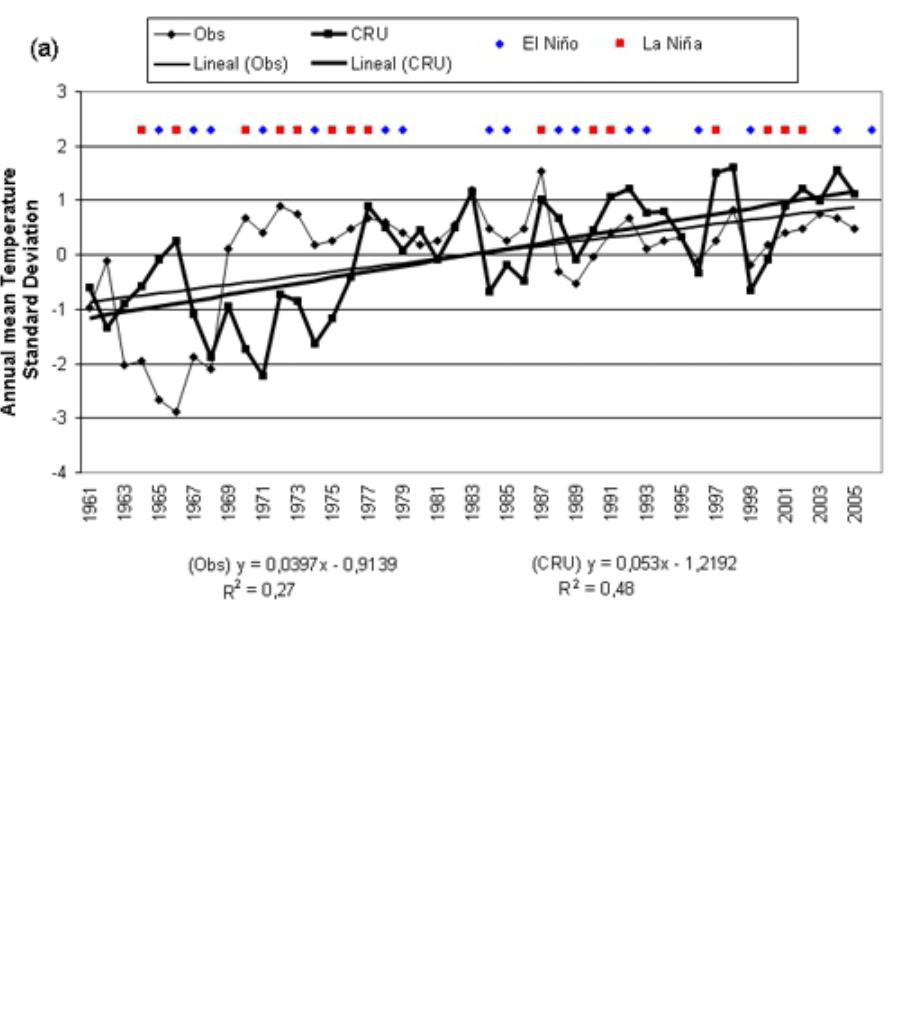
Fig. A.1.1 a . Trends in annual mean temperature from 1961 to 2005 (the data have been standardized to facilitate